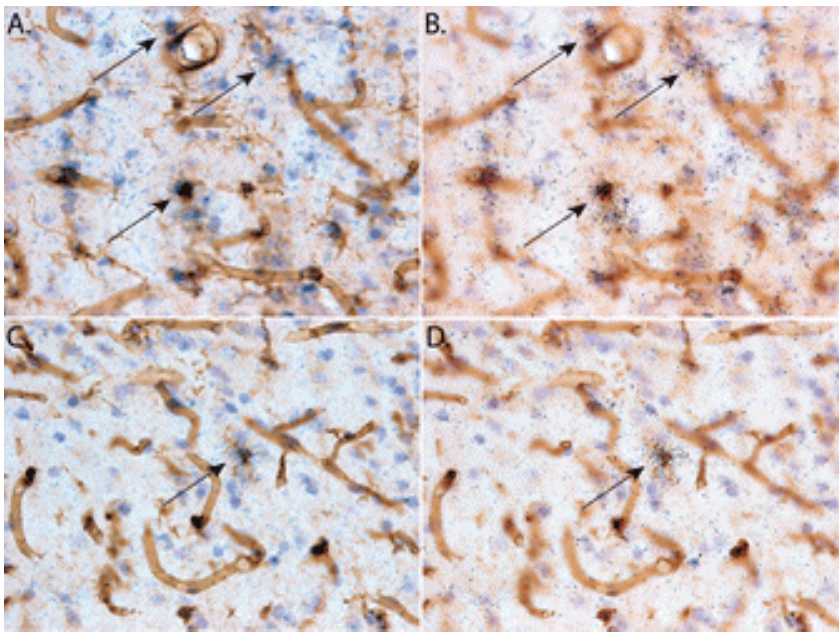
FIGURE 3. Golli-MBP expression is differentially expressed in CNS macrophages during the acute and remission phases of EAE. Panels A and B represent histological sections from the cerebellum of a mouse with acute EAE (complete hind limb paralysis). Panels C and D represent histological sections from the cerebellum of a mouse that was in remission from acute EAE. Microglia, macrophages, and blood vessels are visualized in brown with tomato lectin, nuclei are visualized in blue with hematoxylin, and BG21 mRNA expression was visualized by photographic emulsion grains (black) with 33 P label riboprobes. Arrows indicate a Golli-MBP–expressing, lectin+